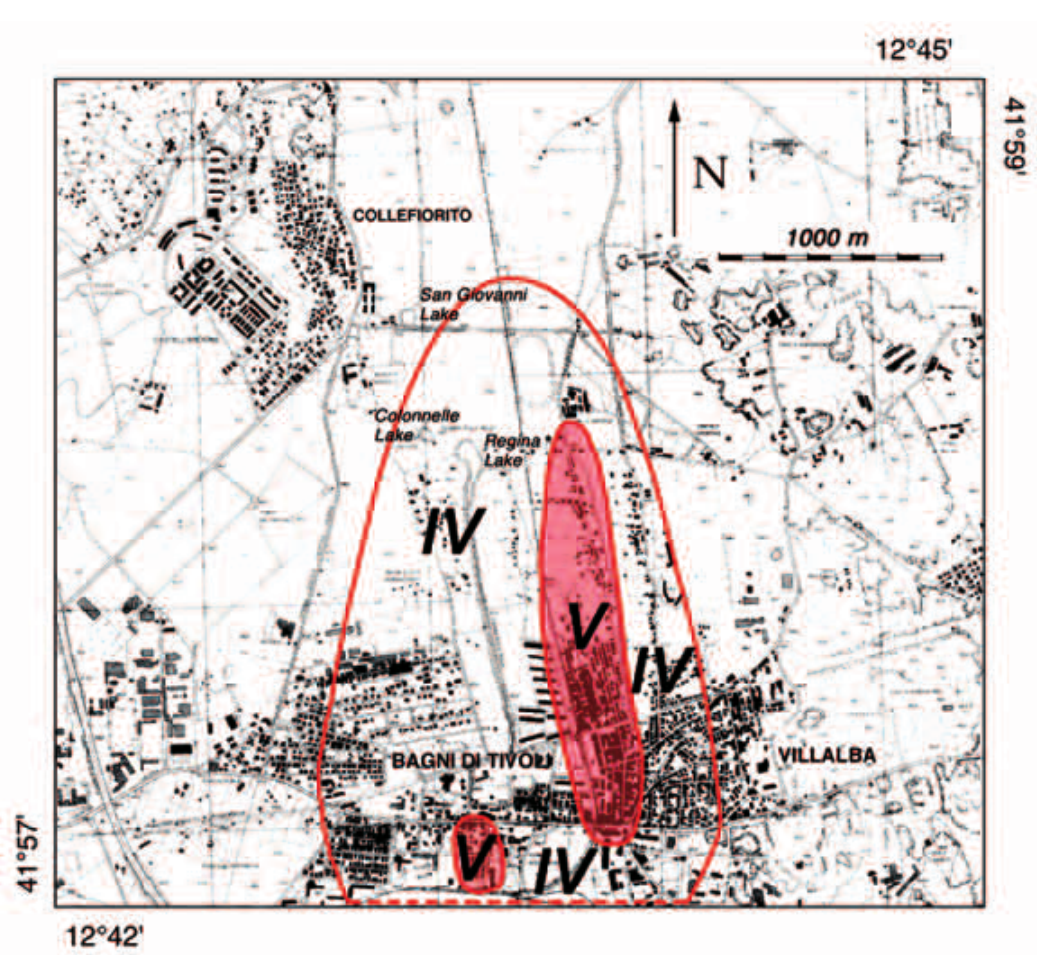
Fig. 6. Macroseismic investigation of the event which occurred on January 31, 2002 at 10:50 a.m.